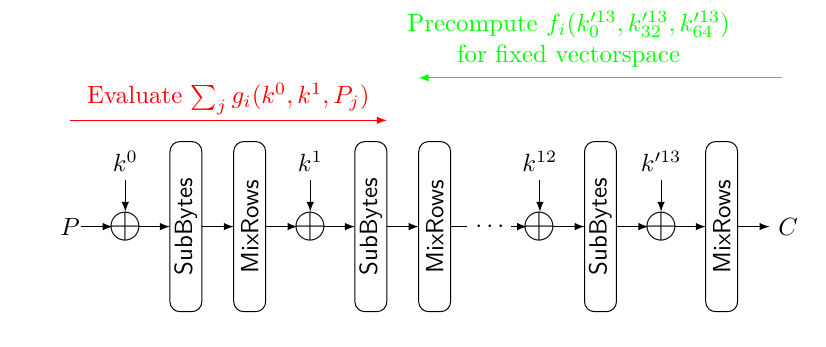
Figure 5: Principle of 13 round